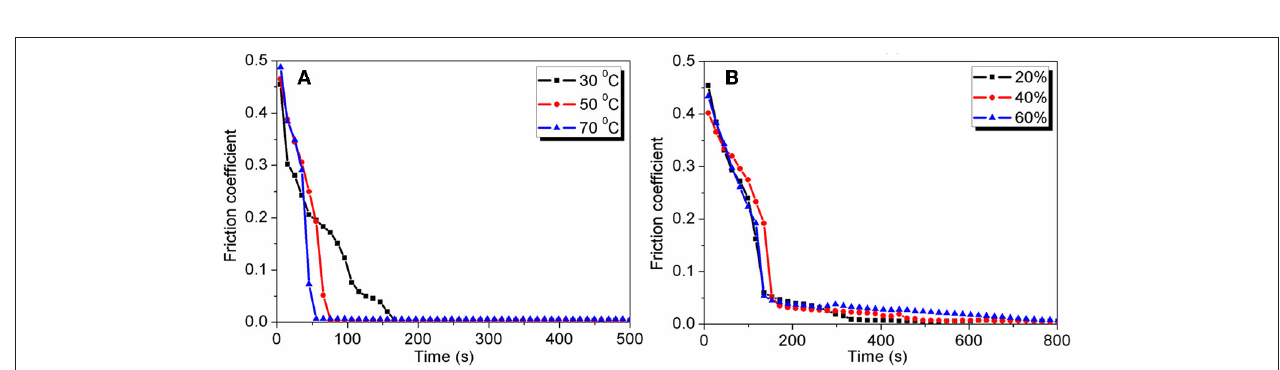
FIGURE 4 | (a) Evolution of the COF with time under lubrication with an H 3 PO 4 aqueous solution (pH = 1.5). Inset is the ball-on-disk model for friction testing. The tribopair is Si 3 N 4 /glass, the load is 3N, and the sliding velocity is 75 mm/s. (Li et al., 2013a) Copyright 2013, AIP Publishing LLC. (b) Schematic of the lubrication model, including three kinds of contacts. Li et al. (2012) Copyright 2012, American Chemical Society.